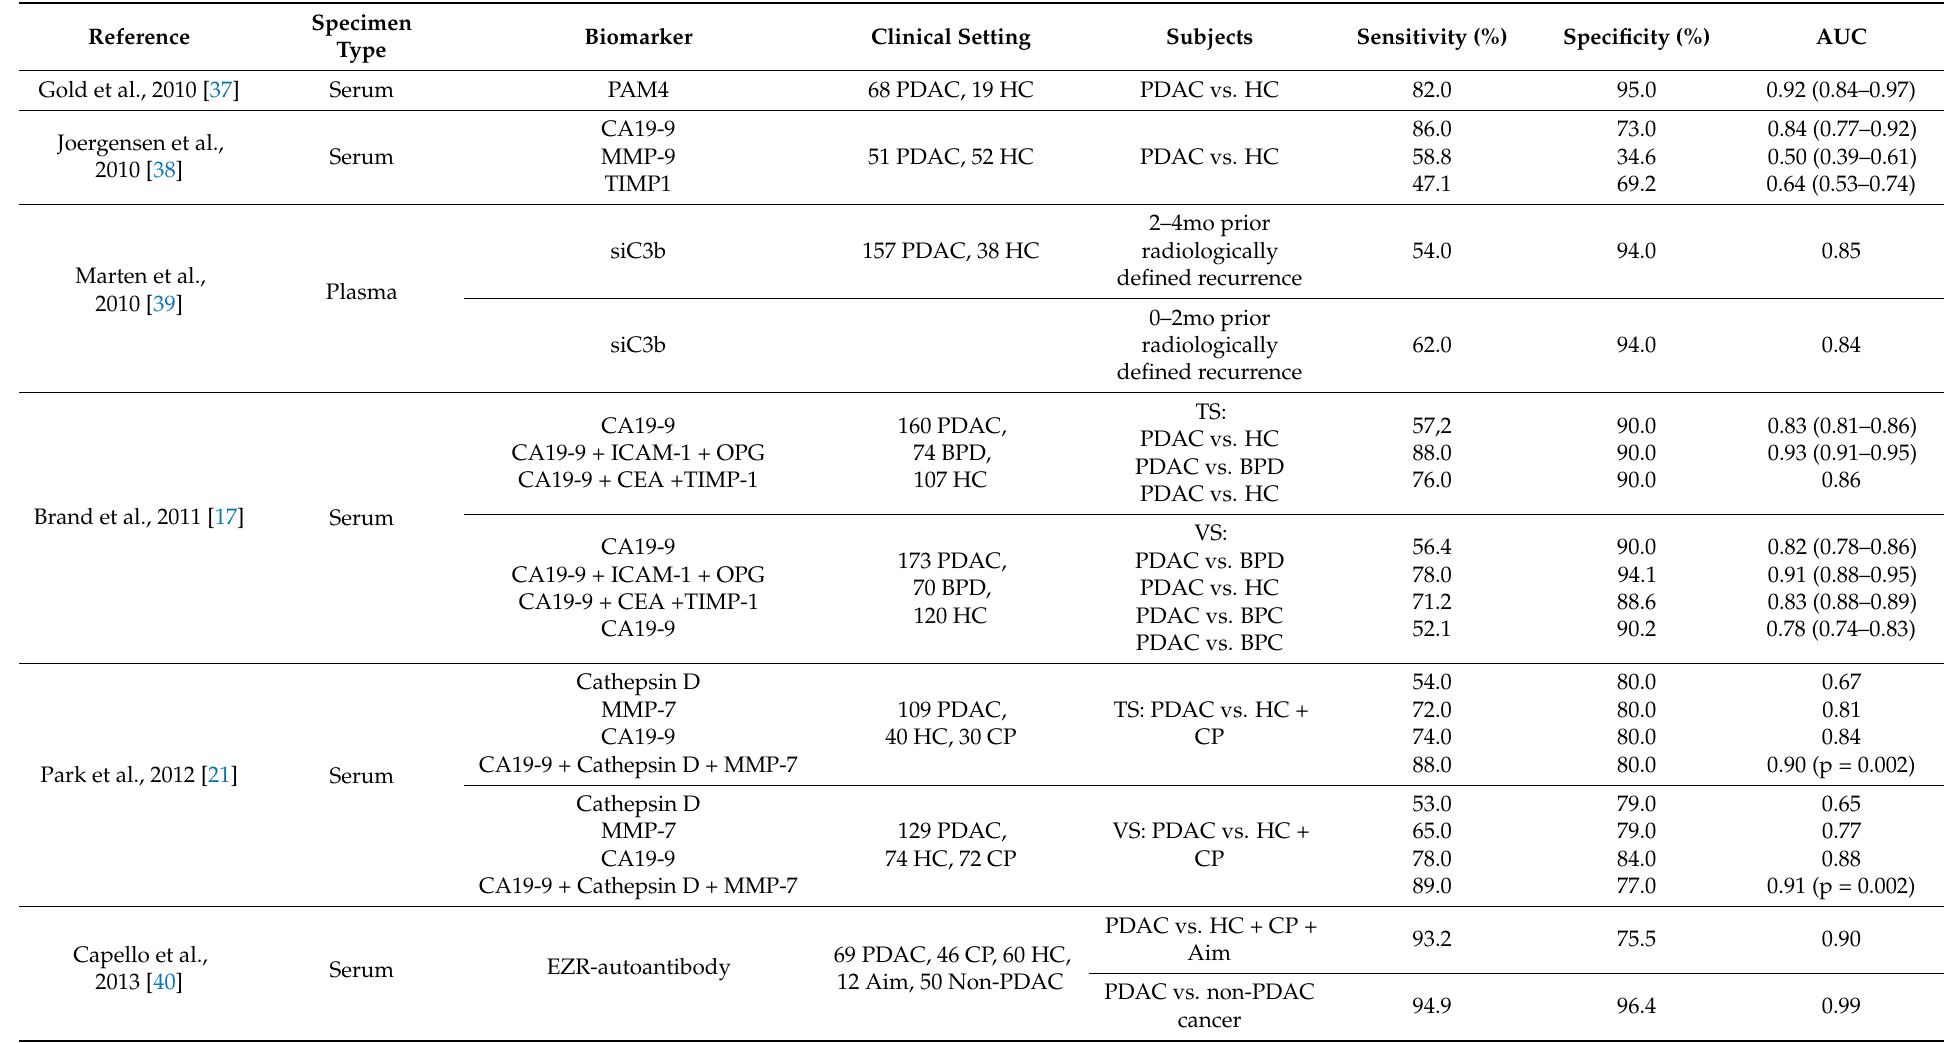
Table 2. Key findings from included